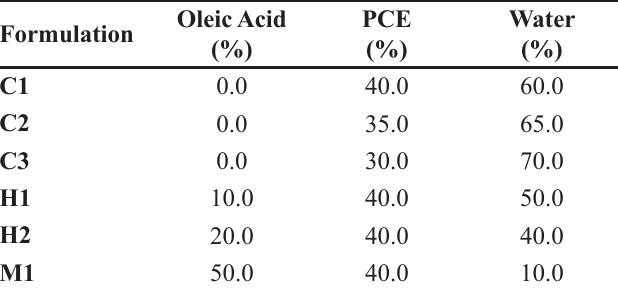
TABLE I - Percentages of components of the formulations